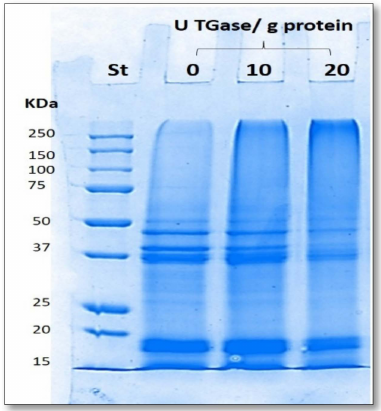
Figure 2. SDS-PAGE profile of film forming solutions (FFSs) previously incubated in the absence or presence of two di ff erent amounts of transglutaminase (TGase). Further experimental details are given in the text.